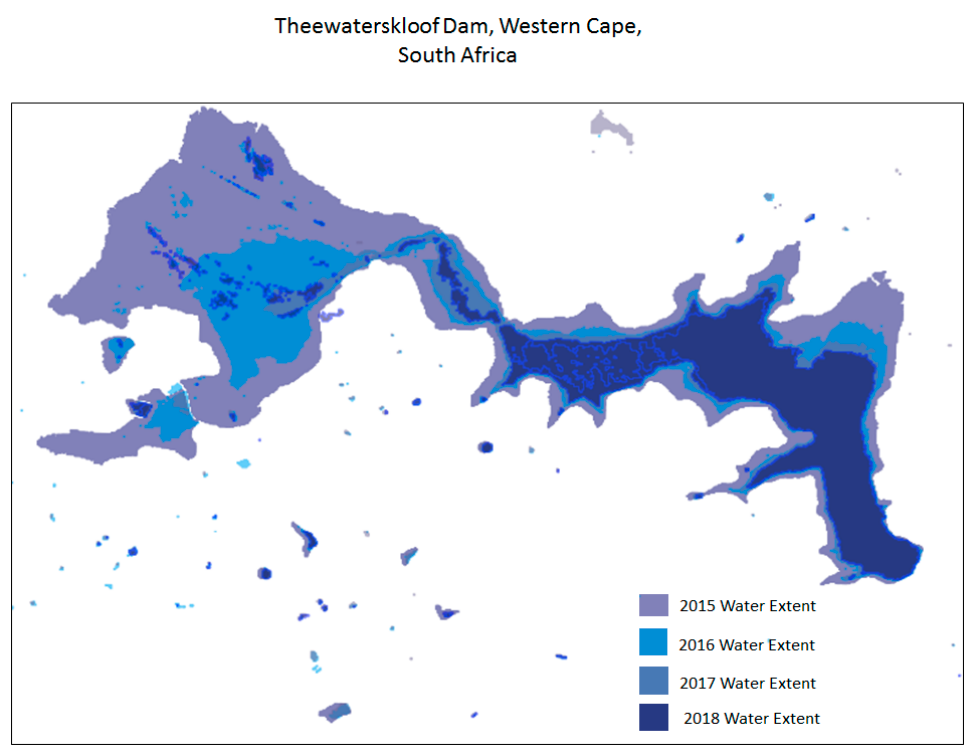
Figure 7. Monitoring of Thewaterskloof Dam in the Western Cape South Africa using time series data.